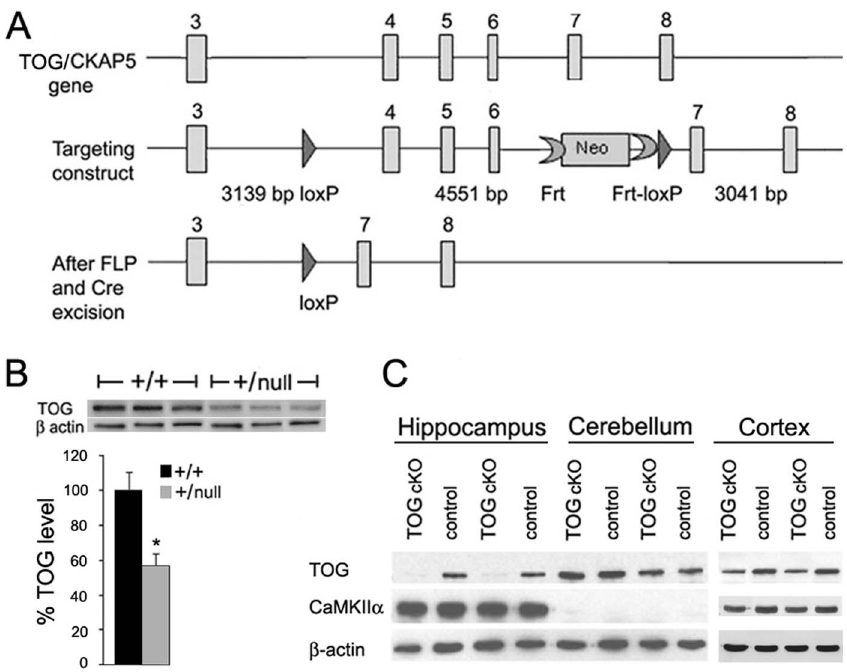
Figure 1. TOG knockout in hippocampal neurons. A. Diagram of the portion of the TOG/CKAP5 gene that is targeted for excision, and the targeting construct. The bottom panel shows the out-of-frame deletion after Cre excision. B. Western blot of brain homogenates from + / + (control) and + /null mice stained with rabbit anti-TOG and mouse anti- b -actin; error bars indicate standard deviations; n=6 animals for each genotype (t-test *p , 0.05). C. Western blot of homogenates from hippocampus, cerebellum and cortex of 2 month old control (wild type) and TOG cKO mice stained with rabbit anti-TOG, mouse anti- a CaMKII and mouse anti- b -actin; n=3 animals for each genotype.